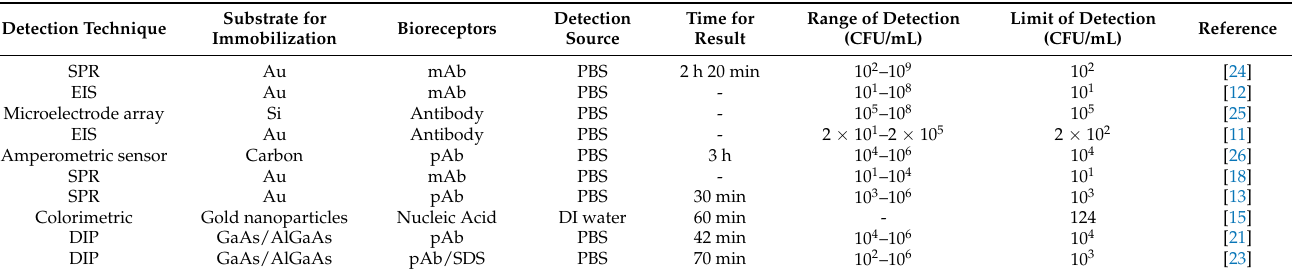
Table 1. Immunosensors proposed for the detection of L. pneumophila . Detection